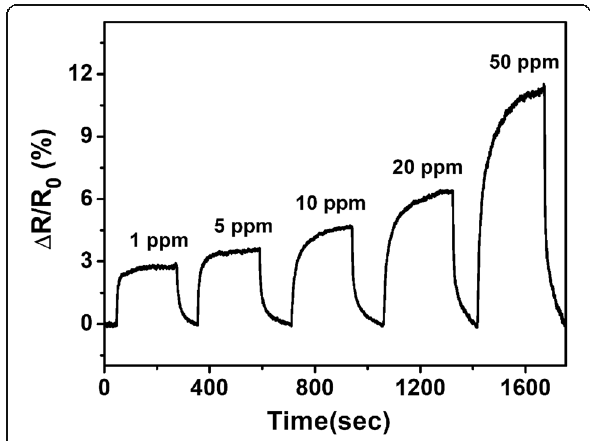
Fig. 6 Plot of normalized resistance change versus time for the sensing device based on rHGO upon exposure to NH 3 with concentrations ranging from 1 to 50